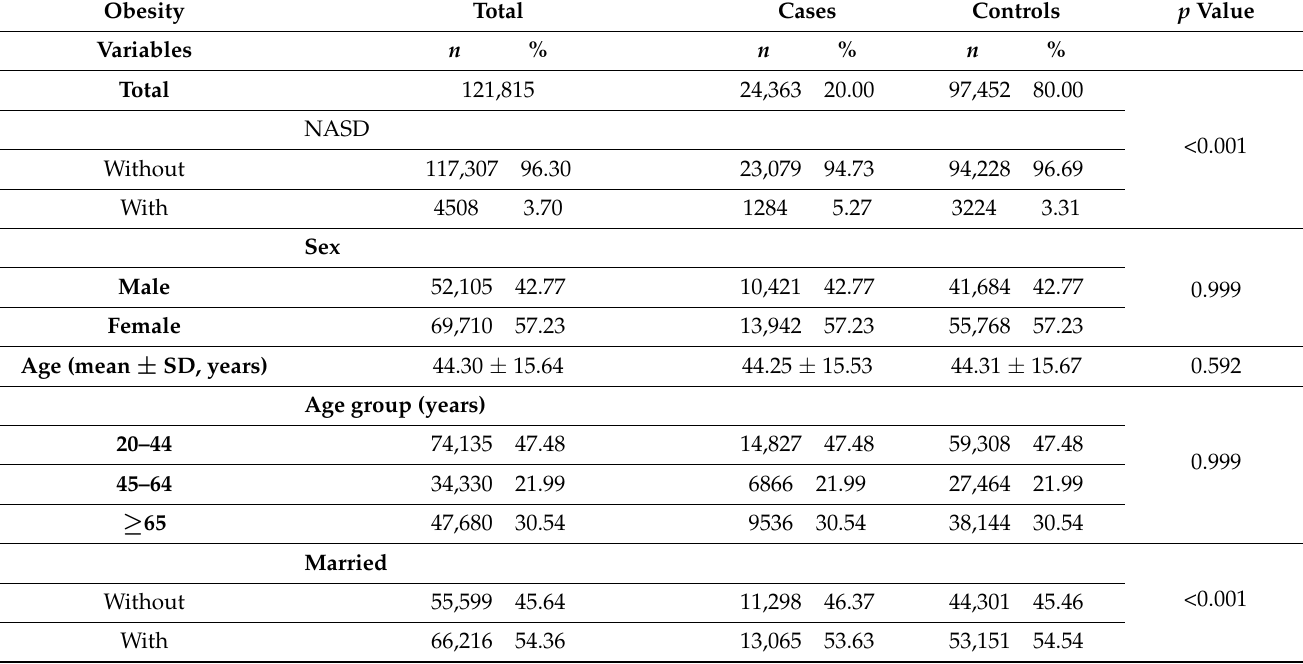
Table 1. Characteristics of